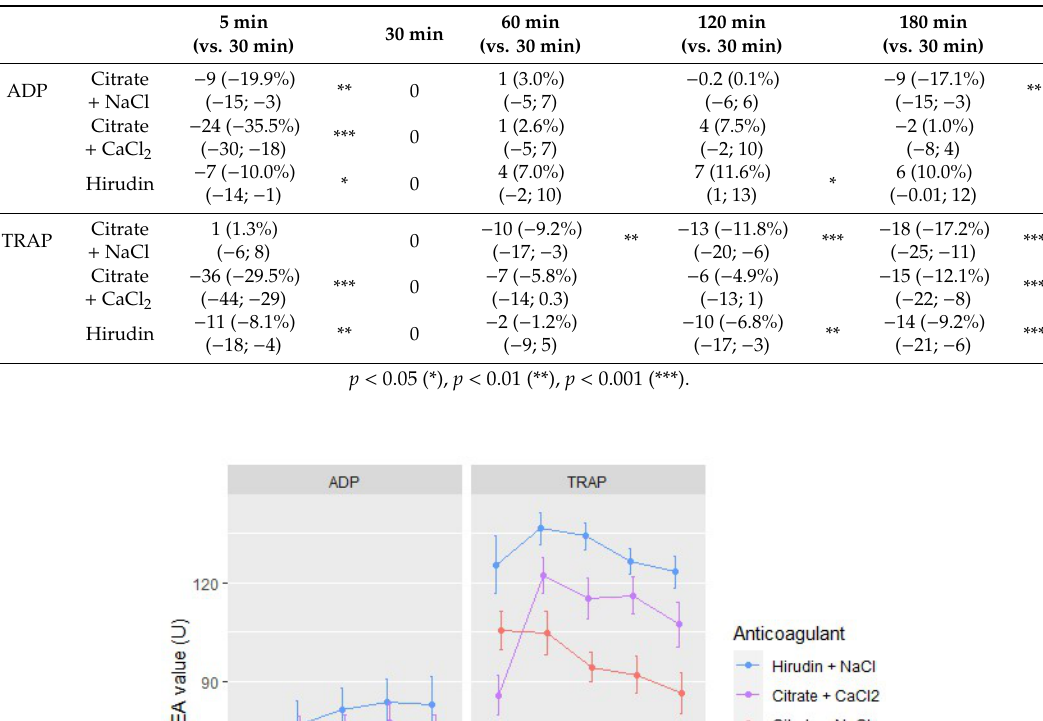
Table 3. Mean di ff erences in MEA results at the five time points (30 min being the reference) for both activators and under the three anticoagulant conditions. MEA values are expressed in arbitrary units. Mean di ff erence, relative di ff erence (%) and 95% confidence interval for the mean di ff erence are given for each value.